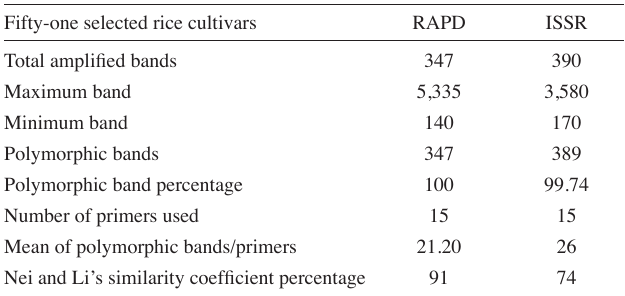
Tab. 2: Efficiency comparison between RAPD and SSR markers for identifying polymorphism among the 51 rice cultivars. Fifty-one selected rice cultivars